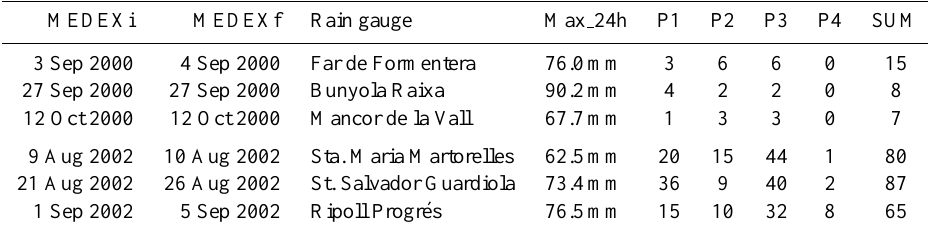
Table 1. Example of the SIR database for HR events. See text for details.